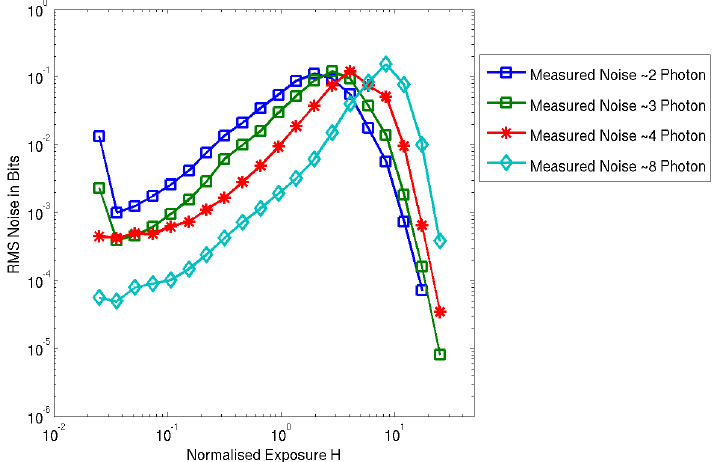
Figure 9. Measured RMS noise in multi-photon threshold oversampled binary imaging.